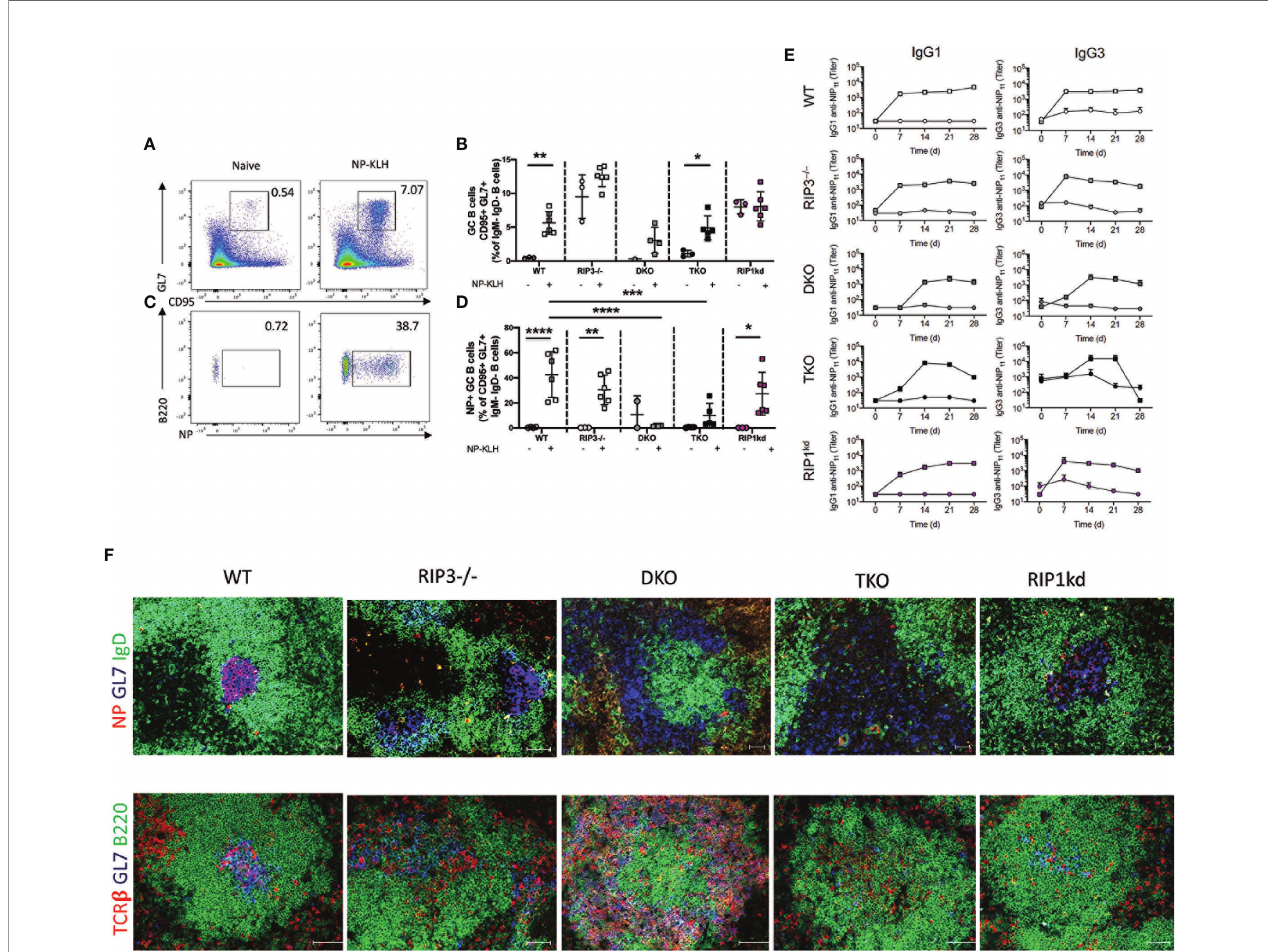
FIGURE 5 | Caspase-8 is required for T-dependent B cell activation and maintenance of GC architecture. Representative fl ow cytometry plots demonstrate gating for frequency of splenic B220 + CD19 + B cells which are GC B cells (GL7 + CD95 + IgM - IgD - ) in naïve mice compared to mice immunized with 100 m g NP-KLH and alum 12 days previously (A) . Total GC B cell frequencies quanti fi ed for naïve or immunized C57BL/6 WT, RIP3-/-, DKO, TKO and RIP1 kd mice (B) . Representative fl ow cytometry plots demonstrate gating for frequency of B220 + CD19 + B cells which are NP-speci fi c GC B cells (NP + GL7 + CD95 + IgM - IgD - ) in naïve mice compared to mice immunized with 100 m g NP-KLH and alum 12 days previously (C) . Antigen speci fi c GC B cell frequencies quanti fi ed for naïve or immunized C57BL/6, RIP3-/-, DKO, TKO and RIP1 kd mice (D) . ELISA detected NP-speci fi c IgG1 and IgG3 antibody titers in serum of C57BL/6 WT, RIP3-/-, DKO, TKO and RIP1 kd mice weekly for 28 days post immunization with 100 m g of NP-KLH and alum (E) . Spleens from NP-KLH/alum immunized mice were labeled with immuno fl uorescent antibodies to identify the T cell zone (anti-TCR b ), B cell follicle (anti-B220), NP-speci fi c B cells (NP-APC), and GCs (anti-GL7) (F) . Data is representative (A, C, F) or a pool (B, D, E) of at least two independent experiments, 3-4 mice per group. Each symbol indicates an individual mouse. *p ≤ 0.05, **p ≤ 0.01, ***p ≤ 0.001, ****p ≤ 0.0001 (one-way ANOVA) Scale bar = 100 m m and represents 2-4 images per slide, 3-6 sections per mouse, and 4-6 mice per group (F)